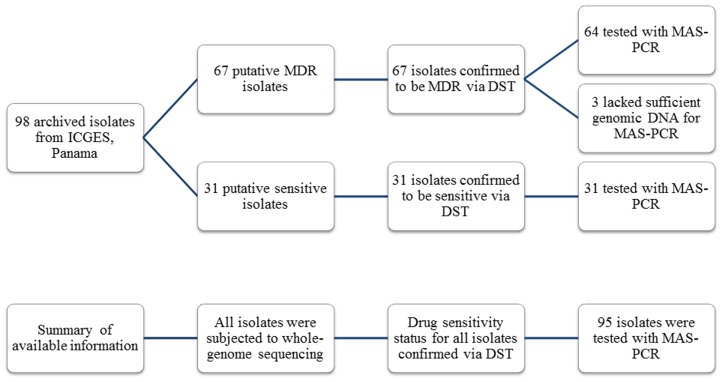
Flow-chart showing available drug susceptibility testing (DST), sequencing, and multiplex allele-specific PCR (MAS-PCR) results for the 98 archived isolates from Panama.